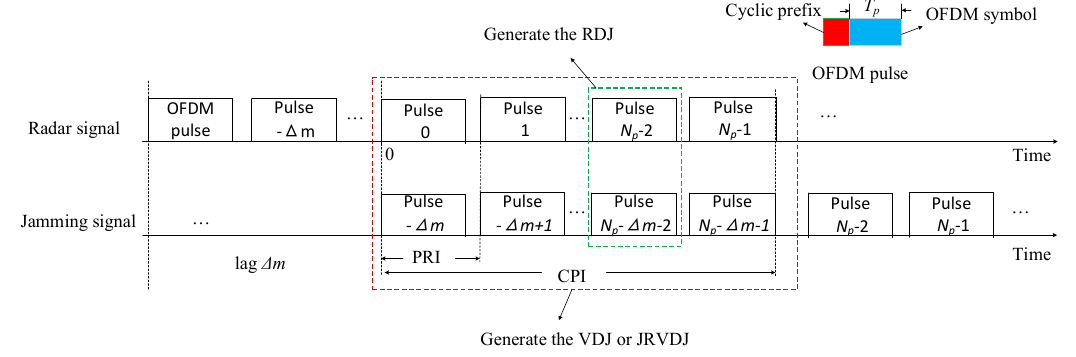
Figure 1. The mechanism of the deception jamming in a CPI with lag ∆ m